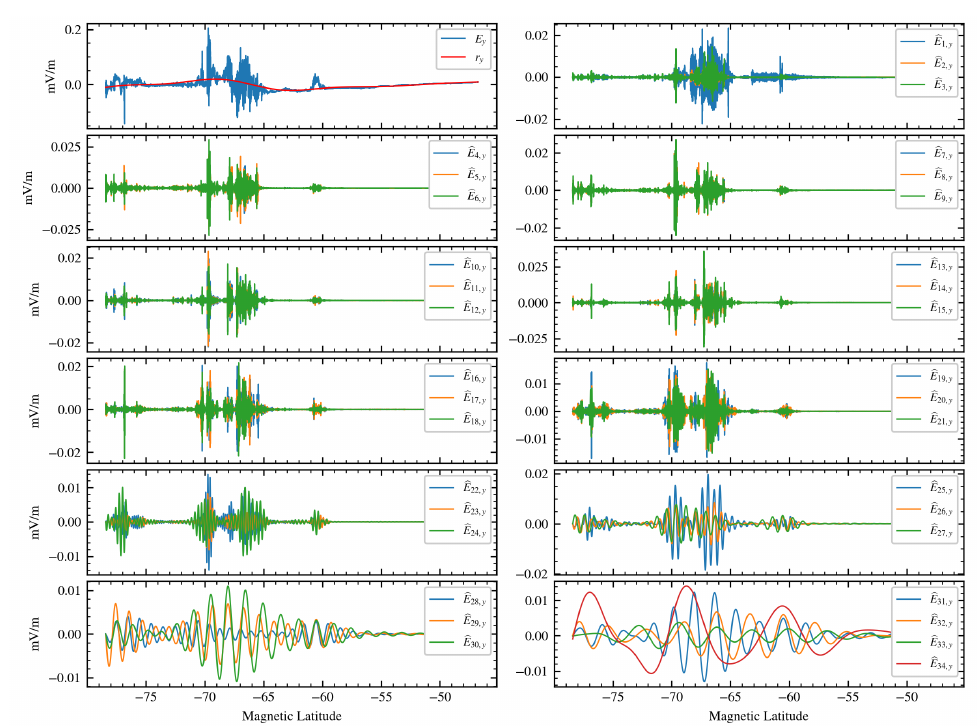
Figure 3. MvFIF decomposition, as introduced in Equation (1), of E y measured by EFD in the selected interval (see Figure 1). ( Top left ): Original field component (blue curve) together with the residual r y from the decomposition (red curve). The other panels show all the extracted IMCs. In total, 35 IMCs were found, from (cid:98) E 1, y to (cid:98) E 35, y